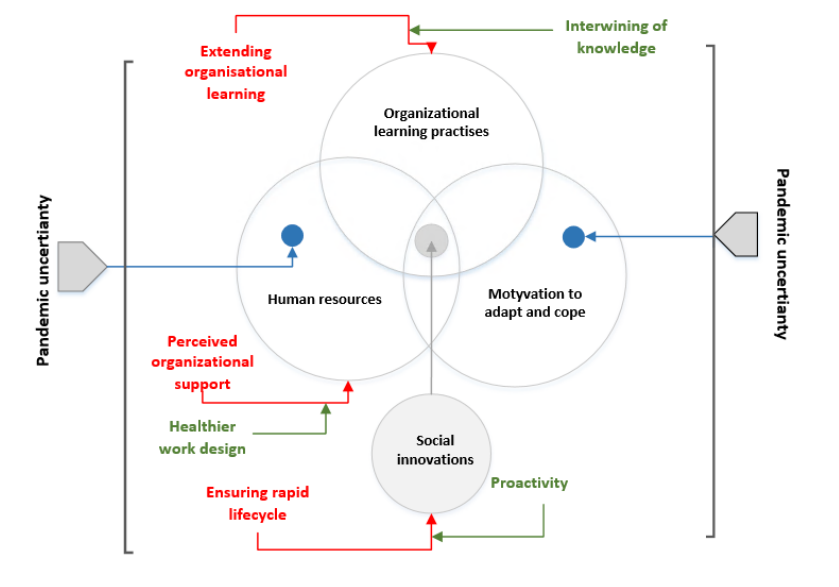
Figure 1. Transforming challenges to the learning organization and organizational creativity response in the context of COVID-19 pandemic uncertainty (source: created by